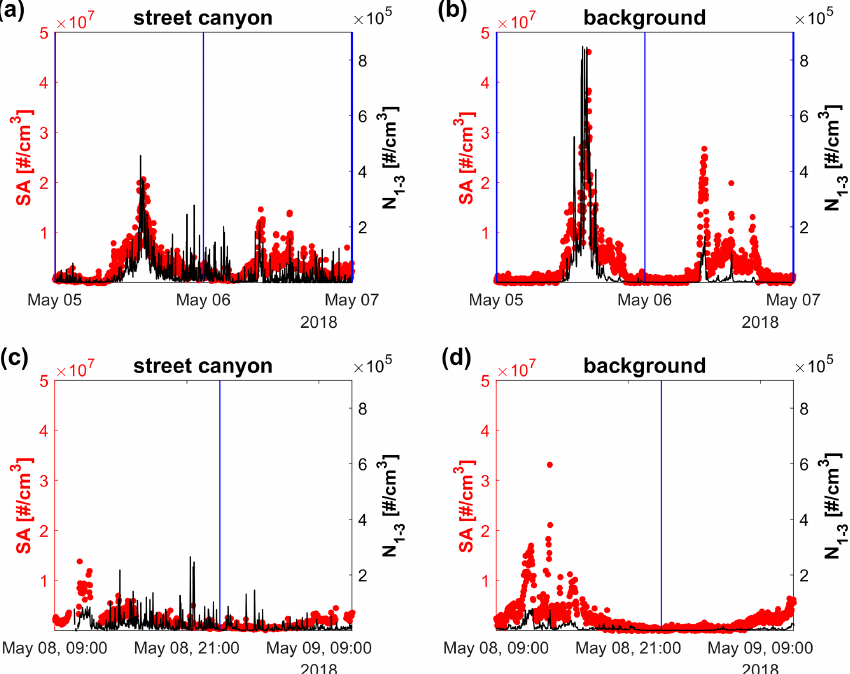
Figure 8. Time series of sub-3nm particles (black) and SA (red) concentrations at the street canyon (a, c) and at the background station (b, d) during 5 May 00:00LT–7 May 00:00LT (a, b) and 8 May 09:00LT–9 May 2018 15:00LT (c, d) . Vertical blue lines indicate midnight. This figure with a logarithmic y axis can be found in Fig.